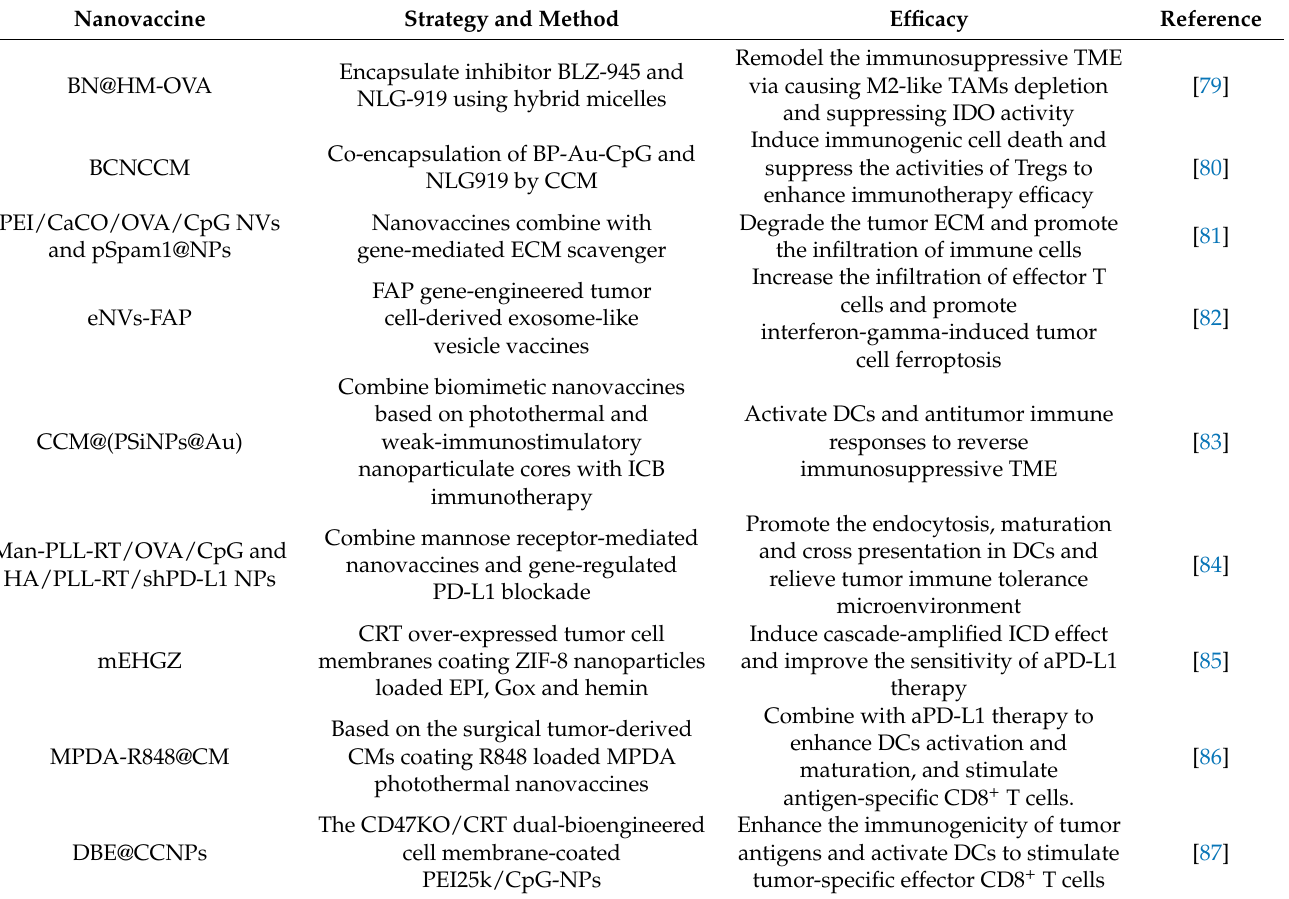
Table 6. The novel strategies of bioactive nanovaccines in immunosuppressive